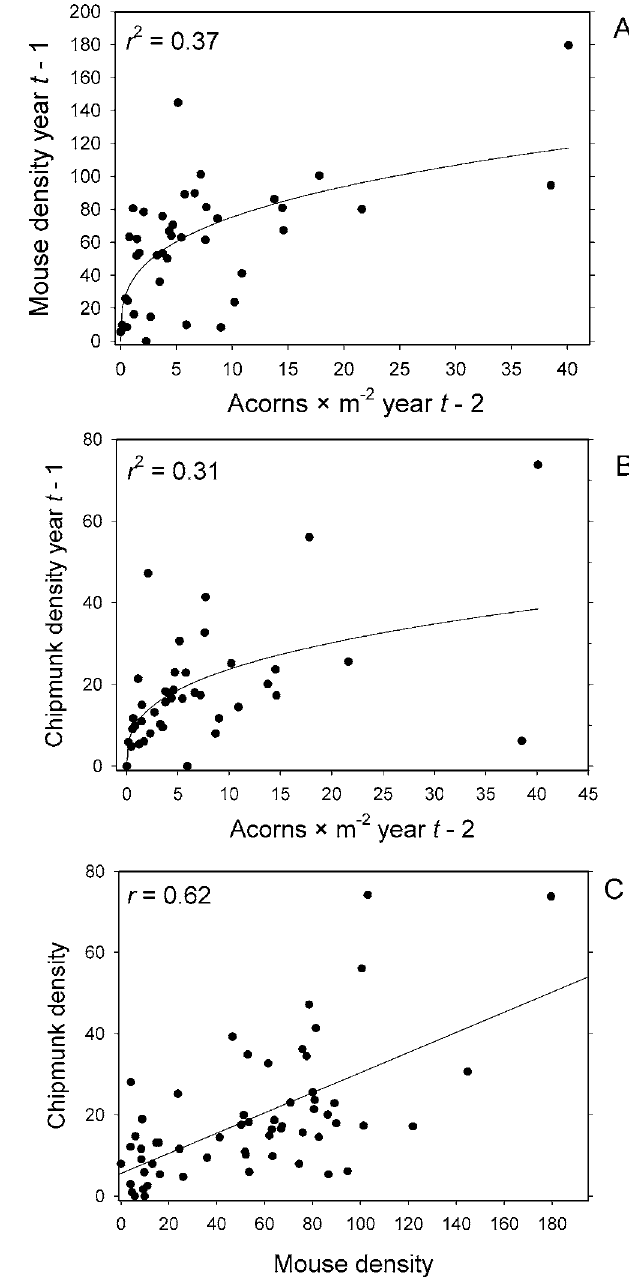
Figure 5. Effects of Acorn Density on Mouse and Chipmunk Densities Shows effects of acorn density (acorns per square meter) in year t (cid:1) 2 on (A) mouse (P. leucopus) density (number per 2.25-ha grid) in year t (cid:1) 1 and (B) chipmunk (T. striatus) density (number per 2.25-ha grid) in year t (cid:1) 1. (C) Correlation between mouse density and chipmunk density across plots and years. DOI: